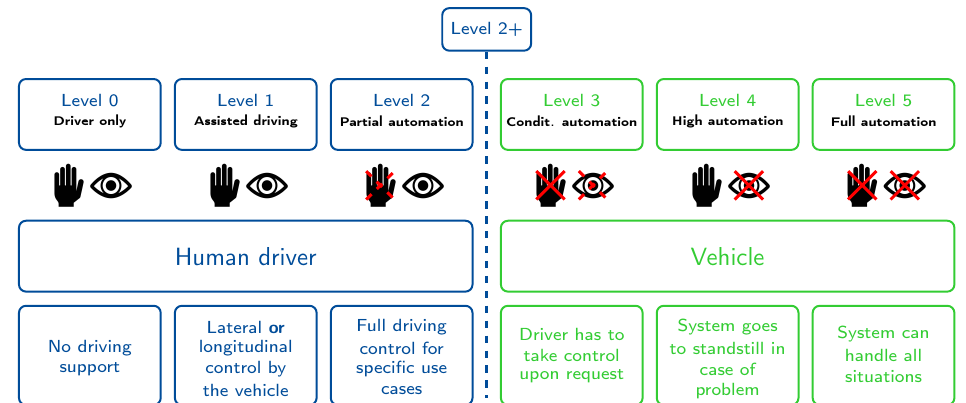
Figure 1. Automated driving (AD) levels according to the definition of the Society of Automotive